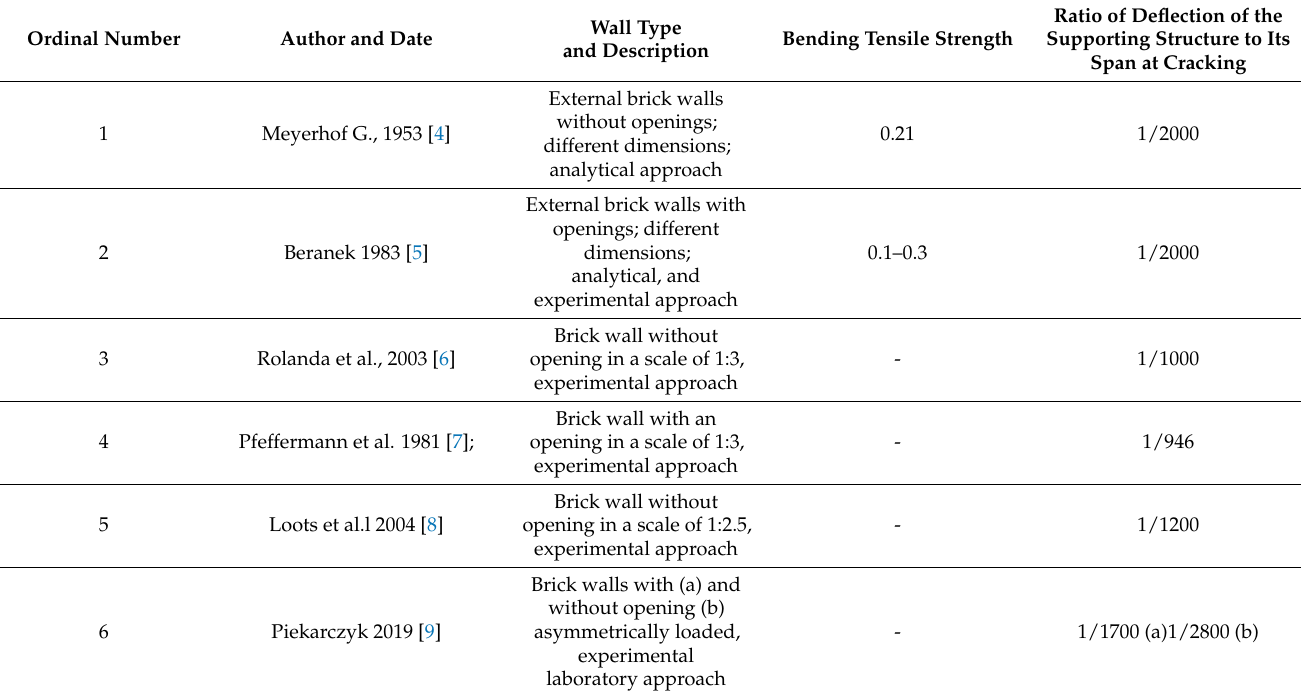
Table 1. Critical deflections and stresses in the state of cracking of brick partition